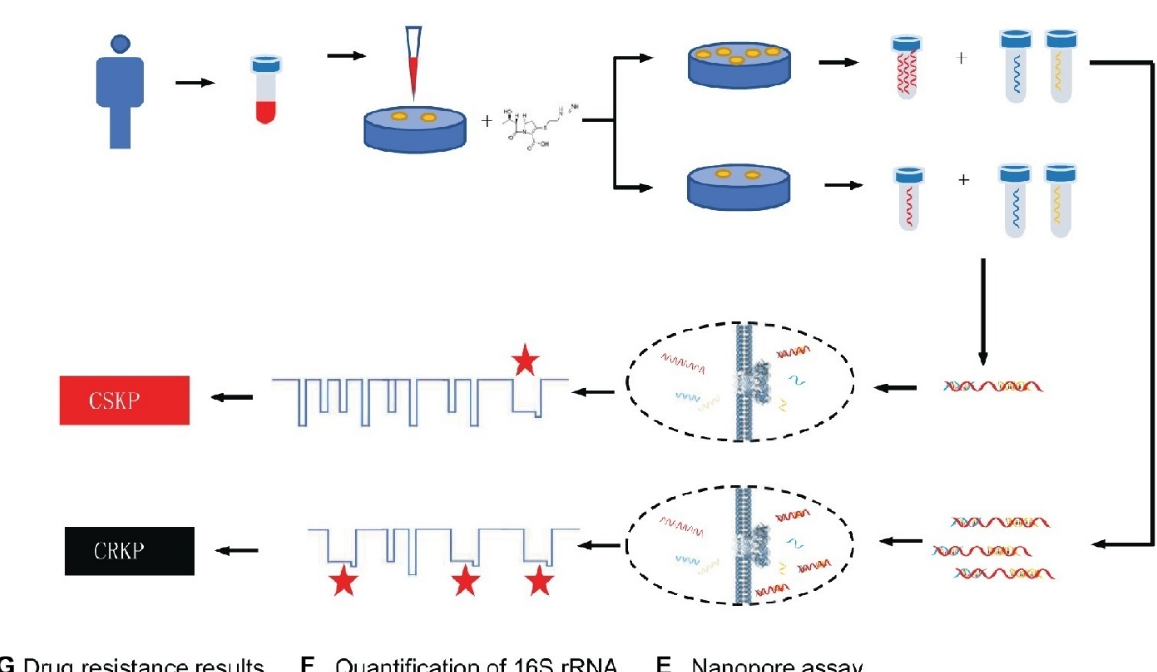
Figure 1. Schematic representation for carbapenem-resistant K. pneumoniae nanopore assay adapted from [70] , Frontiers, 2019.